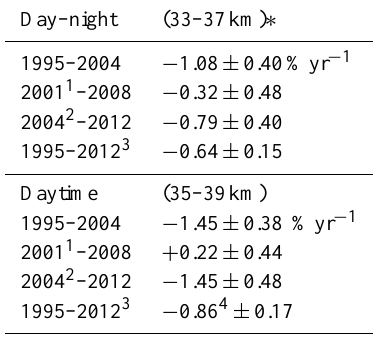
Table 1. Linear trend of Mauna Kea ClO